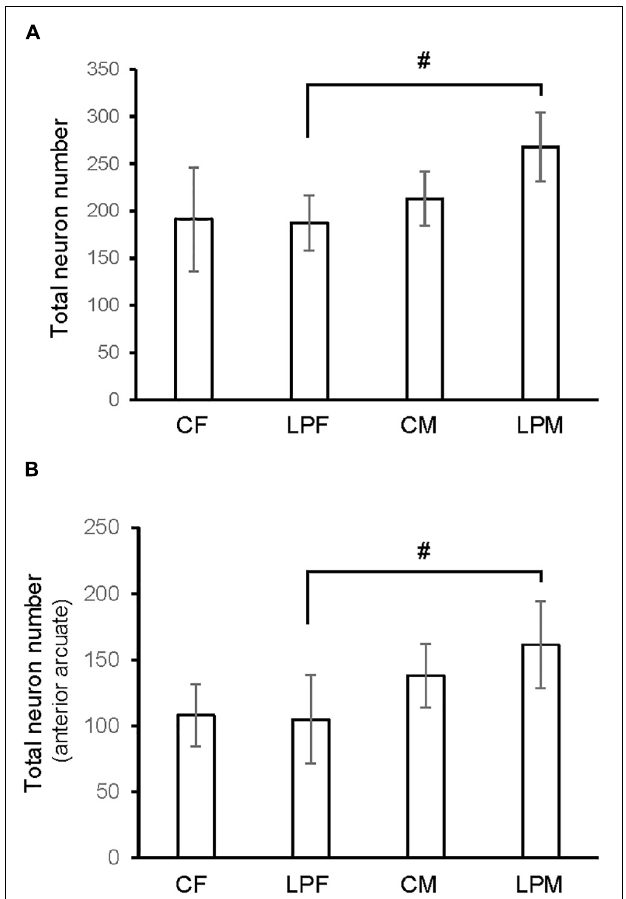
FIGURE 3 | Histogram shows the differences in number of neurons in (A) ARC nucleus (B) anterior ARC subdivision. CM, control male; CF, control female; LPCM, low-protein and low caloric male; LPCF, low-protein and low caloric female. # significant differences between groups ( p < 0.05 in all cases). All values are expressed as means ± SD.